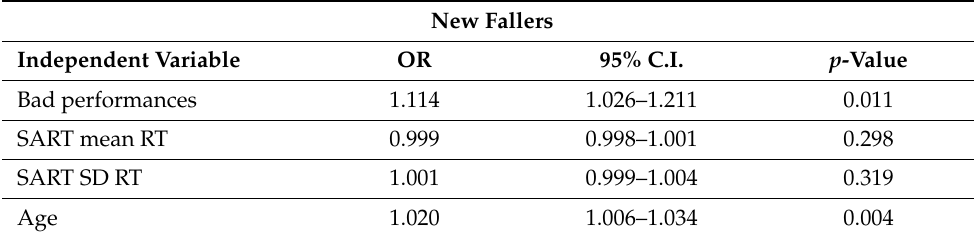
Table A4. Results for the fully adjusted per covariates binary logistic regression model 4 considering bad performances as potential predictor and having New faller as